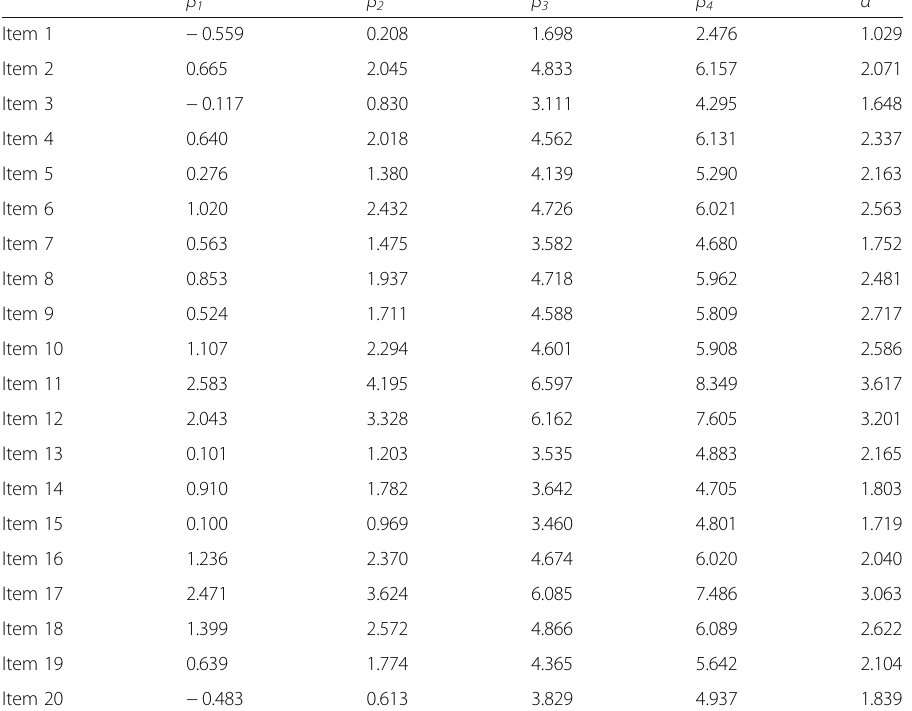
Table 4 Parameter estimates of the graded response model on loneliness